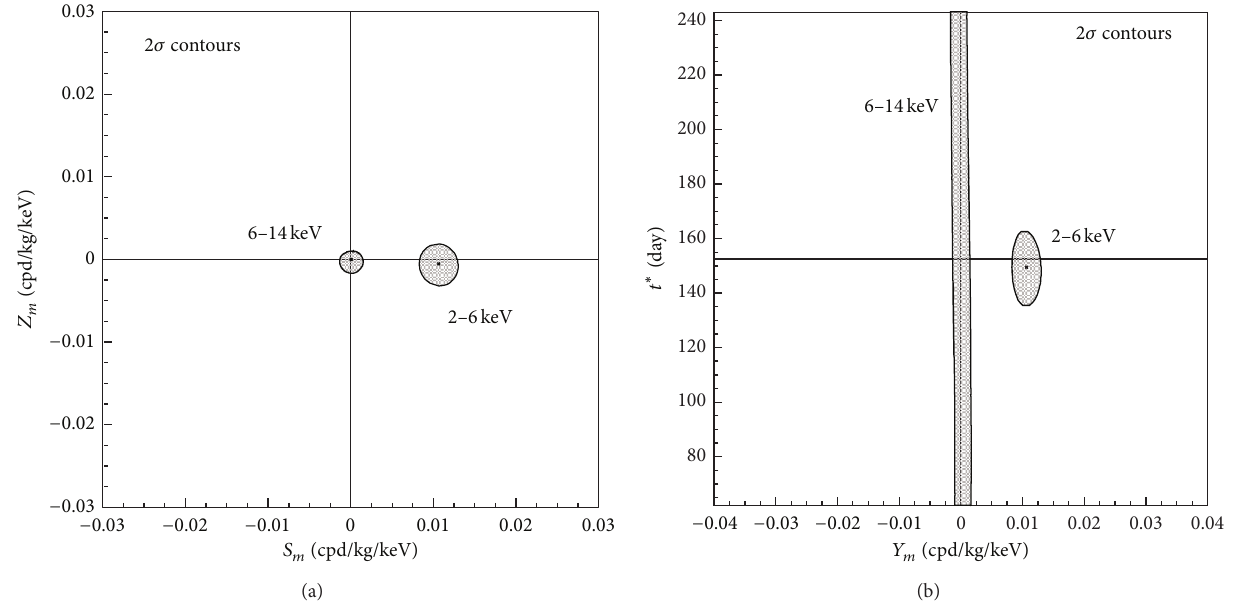
Figure 6: 2𝜎 contours in the plane (𝑆 𝑚 , 𝑍 𝑚 ) (a) and in the plane (𝑌 𝑚 , 𝑡 ∗ ) (b) for the (2–6)keV and (6–14)keV energy intervals. The contours have been obtained by the maximum likelihood method, considering the cumulative exposure of DAMA/NaI and DAMA/LIBRA-phase1. A modulation amplitude is present in the lower energy intervals and the phase agrees with that expected for DM induced signals. See text.